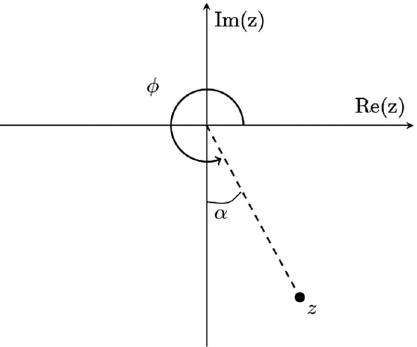
FIG. 2. The angle ϕ is defined to be counterclockwise from the positive real axis and is associated with a circle trigonometry approach. The angle α is provided in the interview prompt as the angle from the negative imaginary axis and is used in the triangle trigonometry